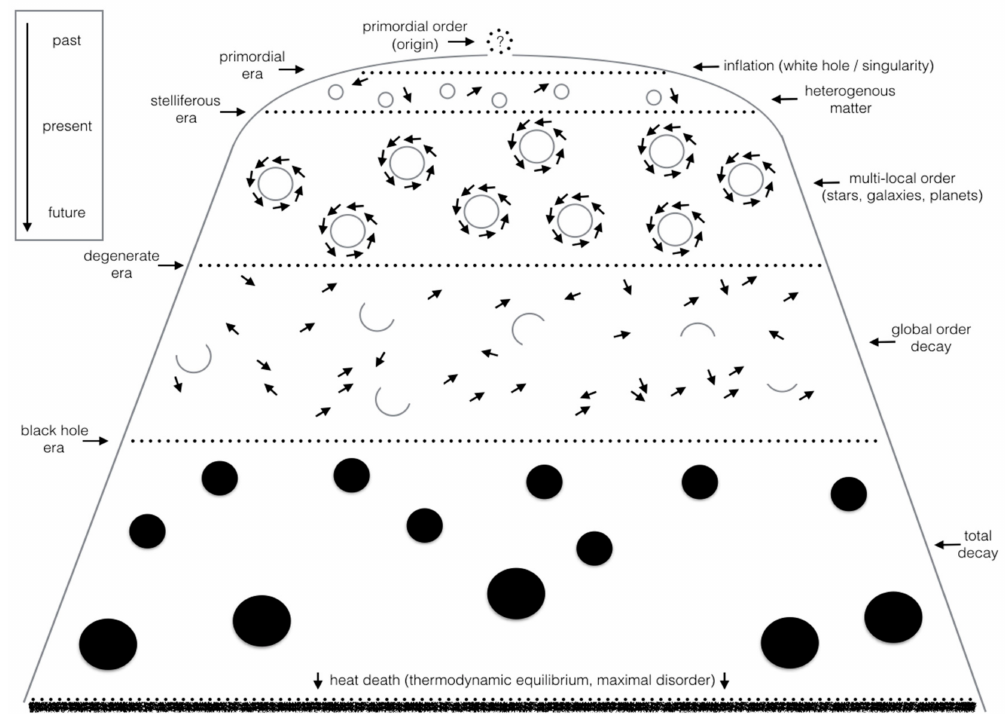
Figure 5. Thermodynamics view of the cosmos, primordial order to final disorder. The thermodynamics view of the cosmos gives the picture of a universe with particular low-entropy, highly ordered or supersymmetrical initial state of being (non-random motion). This initial state drifts towards higher-entropy, global disorder (random motion) over time via symmetry breaking events (divisions) and feedback loops (unities) which generates a motion that we understand as an arrow of time. Consequently, in the context of the universe as a whole (considering the whole of space and the whole of time) the most common state space for matter is general disorganization (thermal equilibrium) due to low material interaction rates, which suggests that the currently observed state of the universe is ultimately unstable. The multi-local material order that does self-organize into persistent temporal form (galaxies, stars, life, mind) occurs due to gravitational attraction acting on heterogeneous distributions of organization which enables higher material interaction rates. In our current understanding of the universe there is no complete theory that explains the fundamental consequence of the emergence of such multi-local order, and reductionist perspectives tend to regard such phenomena as